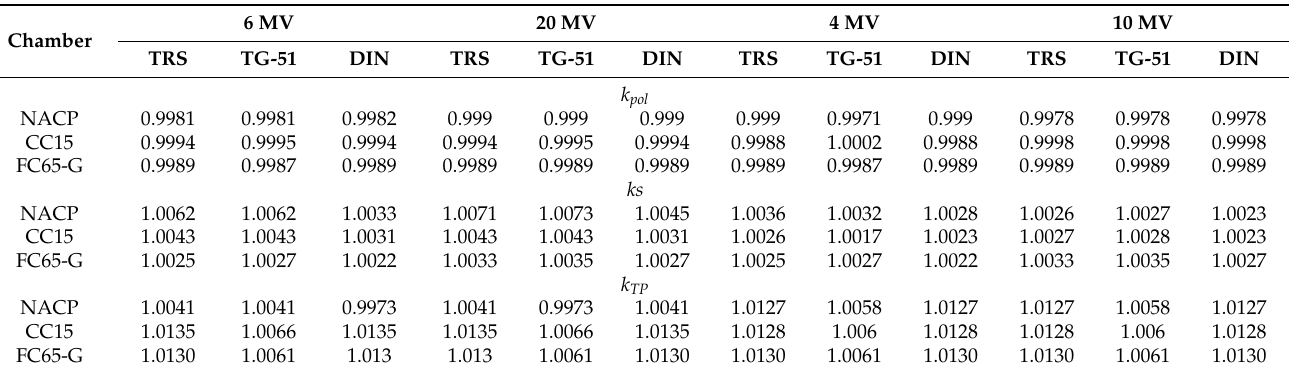
Table 4. Correction factors for the polarity effect ( kpol ), ion recombination ( ks ), and temperature and pressure correction factors ( k TP ).